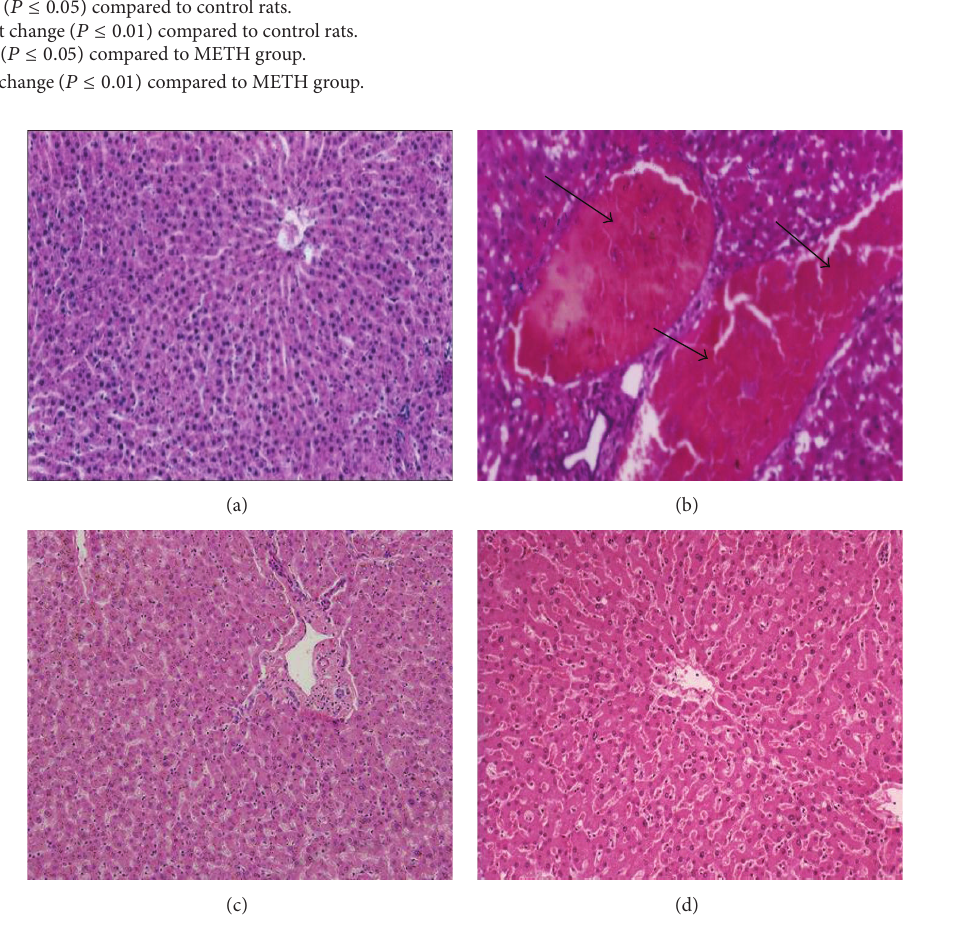
Figure 1: (a) The control group with preserved hepatic architecture (H&E × 200). (b) METH injections caused by a hoop of oedema in the periportal area (arrowhead), which compressed the surrounding hepatocytes. The intracytoplasm vacuolation was found (H&E × 400). (c) Pretreatment of chlorogenic acidwith preserved hepatic lobular architecture. The hepatocytes are within normal limit and preserved its plate pattern. Liver almost returns to the normal pattern (H&E × 200). (d) Pretreatment of caftaric acid to METH injected rats with large reserved hepatic lobular architecture and the liver almost returns to the normal pattern (H&E ×